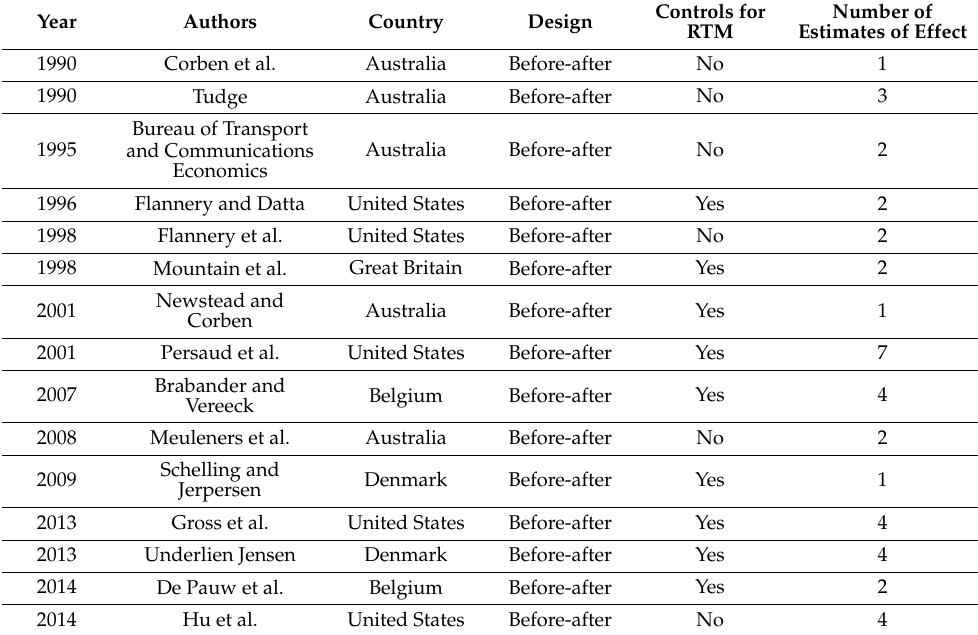
Table 2. List of Studies [13–60] Included in the Meta-Analysis-Based Research Conducted by Elvik (2017)